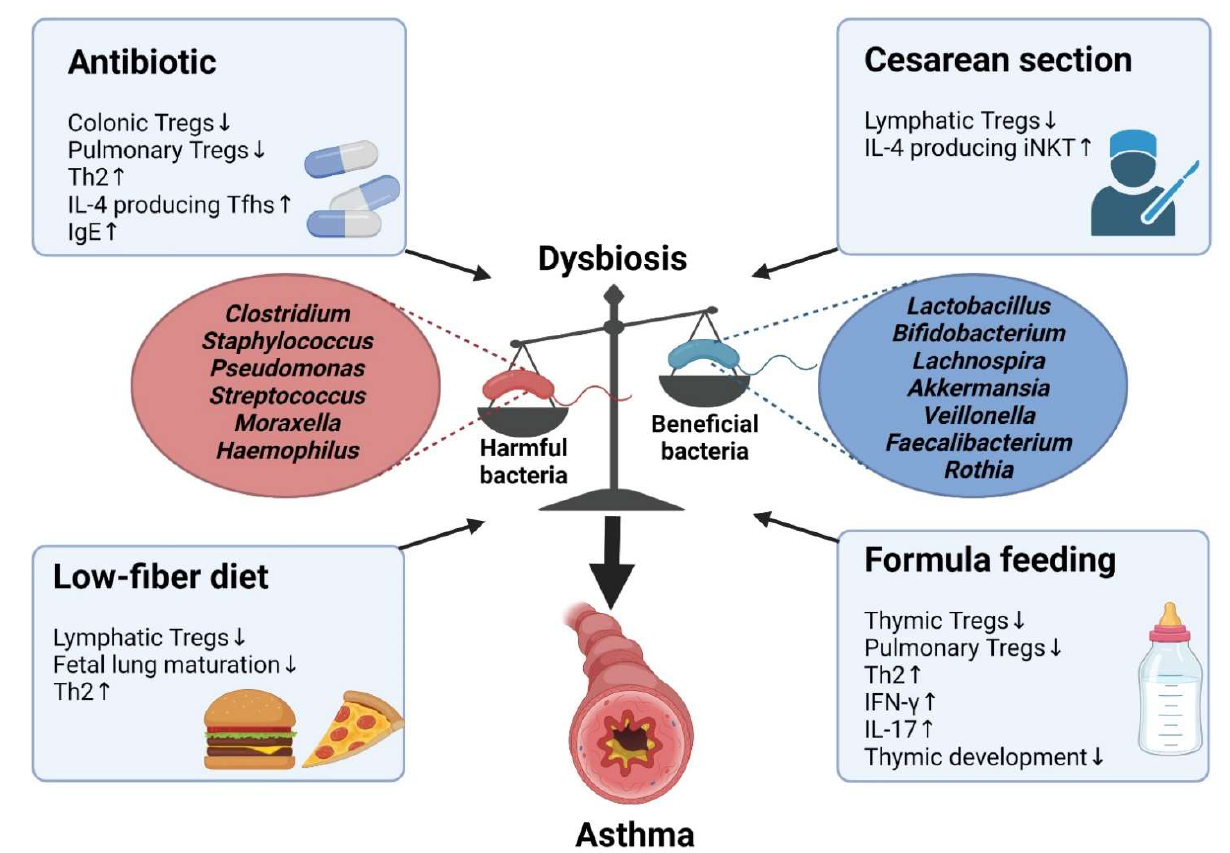
Figure 3. Development of dysbiosis-induced asthma. Beneficial bacteria suppress asthma, whereas harmful bacteria induce asthma. Dysbiosis can be caused by many factors, such as antibiotic use, cesarean section, low-fiber diet, and formula feeding. Dysbiosis influences the differentiation of T cells, resulting in asthma development. Tregs, regulatory T cells; Tfhs, T follicular helper cells; IgE, immunoglobulin E; iNKT, invariant natural killer T; IFN-γ, interferon gamma. The figure was created using BioRender.com (accessed on 6 September 2021).